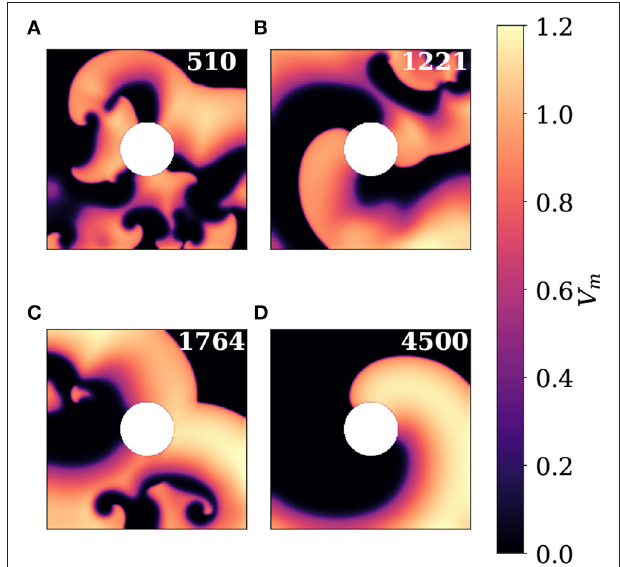
FIGURE 9 | Snapshots showing different regimes of complexity in the 2D simulation dataset. The white circle in the center is a non-conductive heterogeneity. (A) Frame 510 showing lots of interacting spiral waves. (B) Frame 1221 is taken from a regime with two spirals pinned to the heterogeneity and some remaining complex activity in the top right quadrant. (C) In frame 1764 several spiral waves contained mostly in the lower left triangle of the domain generate synchronized plane wave activity that travels to the upper right corner. (D) A single pinned spiral wave remains until the end of the video. This snapshot shows frame